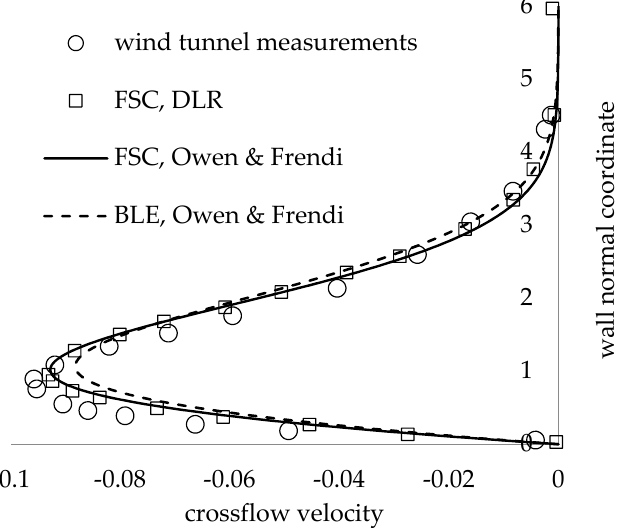
Figure 4. Velocity profiles in the crossflow direction at 80% chord.